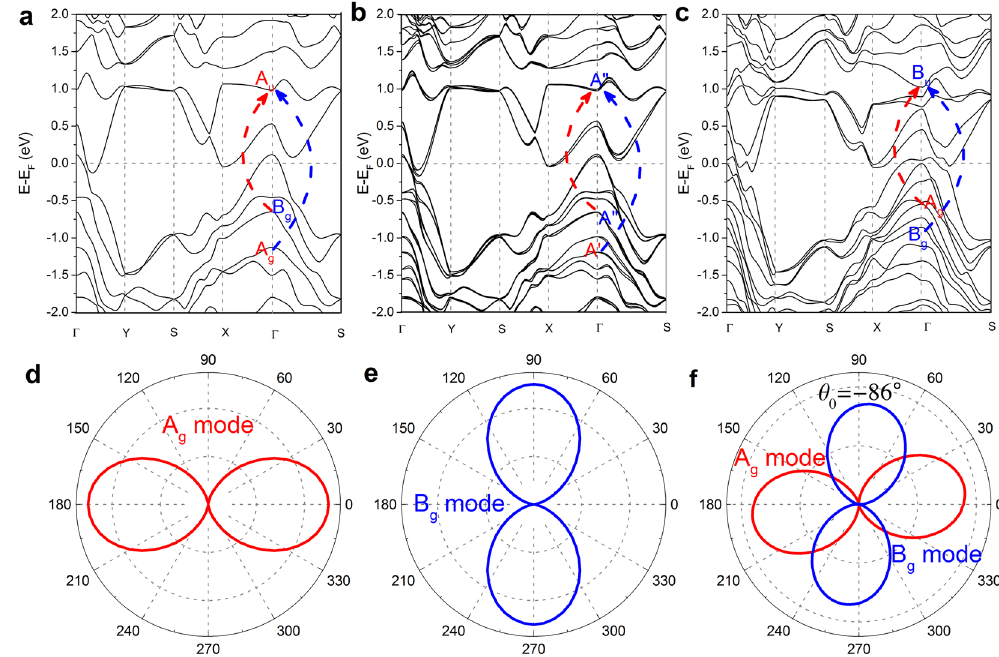
Figure 5. The density functional calculated band structure of ( a ) single-layer, ( b ) bilayer and ( c ) bulk 1 T´- MoTe 2 , the band symmetries in the Brillouin zone center Г point are labeled, and A g ( A ′ , A u ) and B g ( A ″ , B u ) bands are indicated by red and blue labels, respectively. Calculated polarization dependence of the optical transition probability ( d ) with the maximum a -axis polarization ( A g mode) and ( e ) the maximum b -axis polarization ( B g mode). The 0° (90°) corresponds to the a -axis ( b -axis) of the 1 T´-MoTe 2 sample. ( f ) Calculated polarization- dependence of the A g and B g phonon mode intensities, from the incident polarization rotation